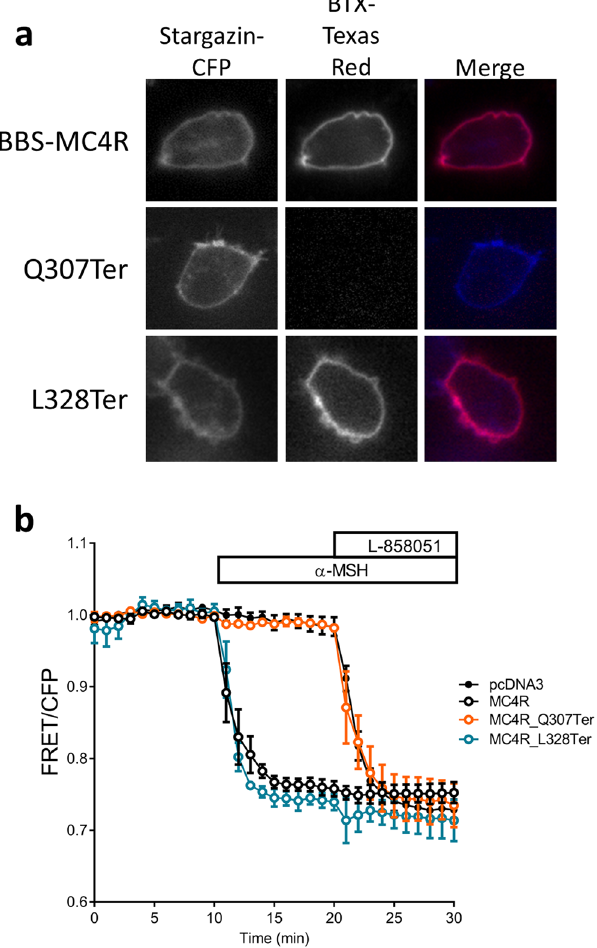
Figure 2. MC4R truncations identified in patients affect cell surface expression and signaling. ( a ) Cell surface localization, indicated by overlap with Stargazin-CFP which is a marker for the membrane, of truncated BBS- MC4R labeled with bungarotoxin-Texas Red expressed in HEK293 cells. ( b ) cAMP production depicted as reduced FRET in HEK293 cells expressing the EPAC sensor with either the wild-type or truncation mutants of MC4R found in our patients. Stimulation with MC4R agonist α -MSH (100 nM) results in robust changes in FRET for the WT and L328Ter while mock transfected cells and those expressing Q307Ter did not respond to α -MSH. The cyclase activator L-858051 (100 µ M) was added at the end to activate maximum cAMP response. These data represent the mean ± S.E.M. of three independent replicate experiments where at least 10 cells were imaged per